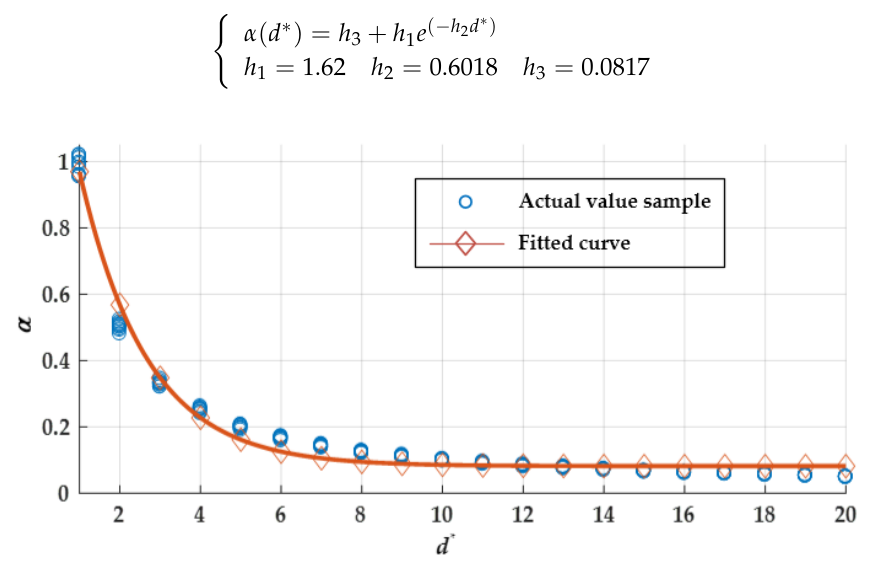
Figure 2. Least square method fitted curve and actual value sample.